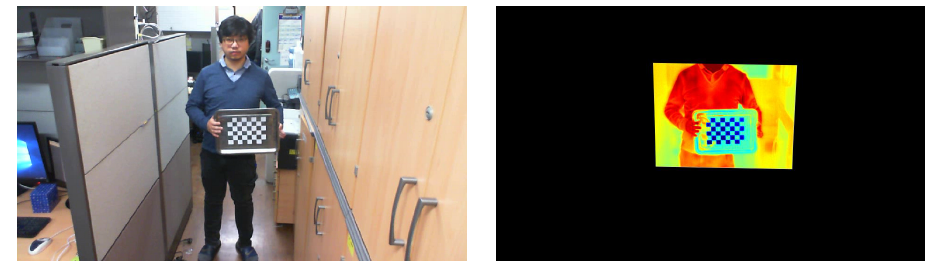
Figure 2. The registration result based on the